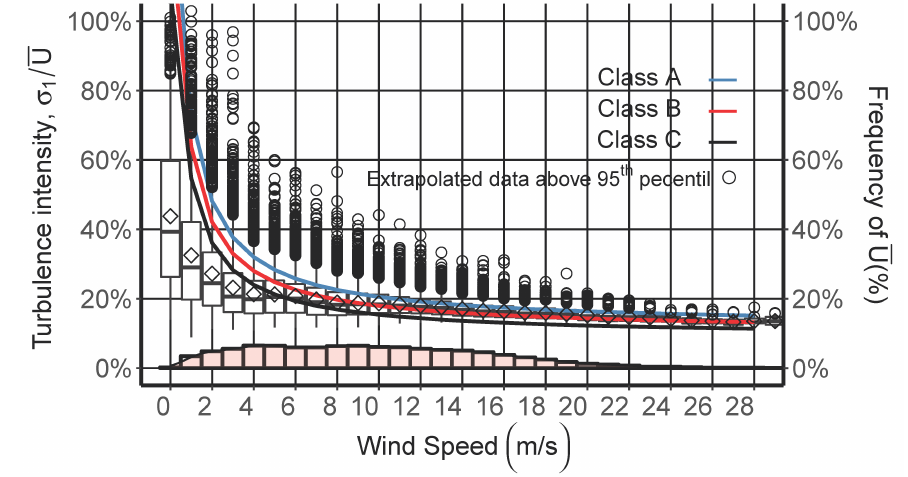
Figure 14. Box plot with the NTM model of IEC61400-1 using different classes for extrapolated data at 75 meters high. The diamond shape located inside the box shows the average turbulence intensity value, and the histogram represents the wind speed frequency distribution.